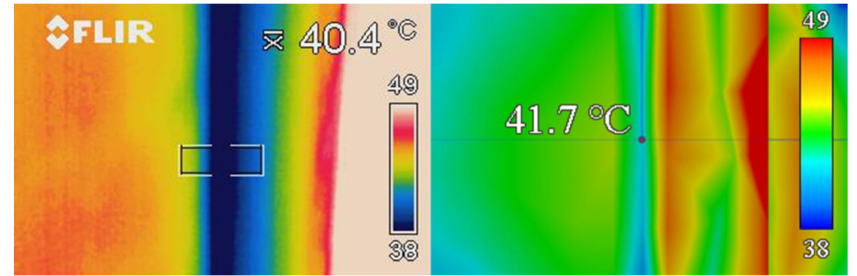
Figure 12. Comparison between data obtained using the thermal camera and data simulated by CFD analysis at a pillar of the south wall.